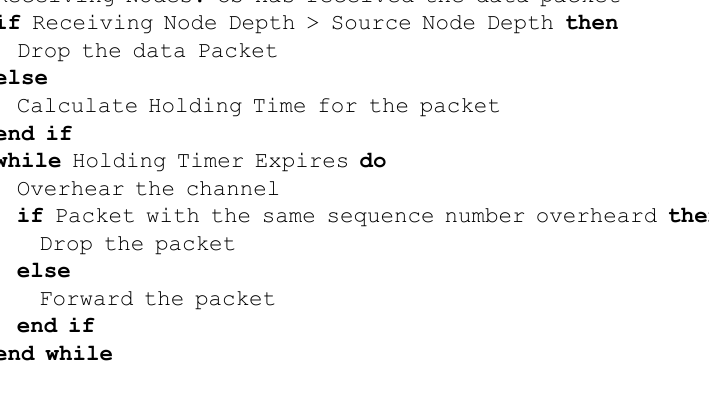
Algorithm 1 Source is ready to send data